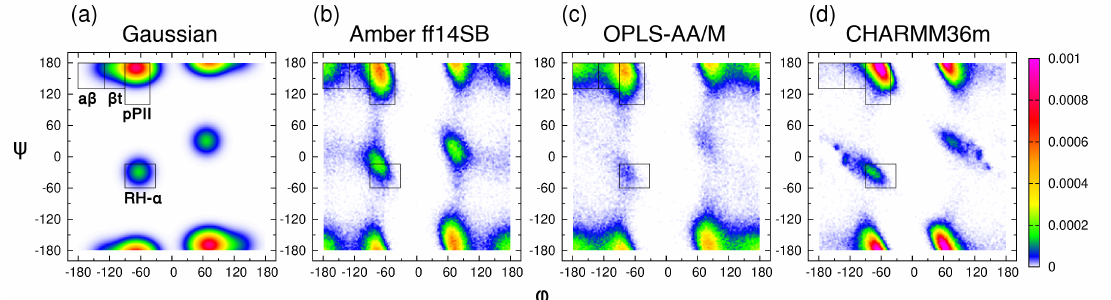
Figure 1. Ramachandran distributions of the central glycine in GGG from ( a ) the Gaussian model and MD with ( b ) Amber ff14SB, ( c ) OPLS-AA/M, and ( d ) CHARMM36m. The rectangular boxes correspond to the four